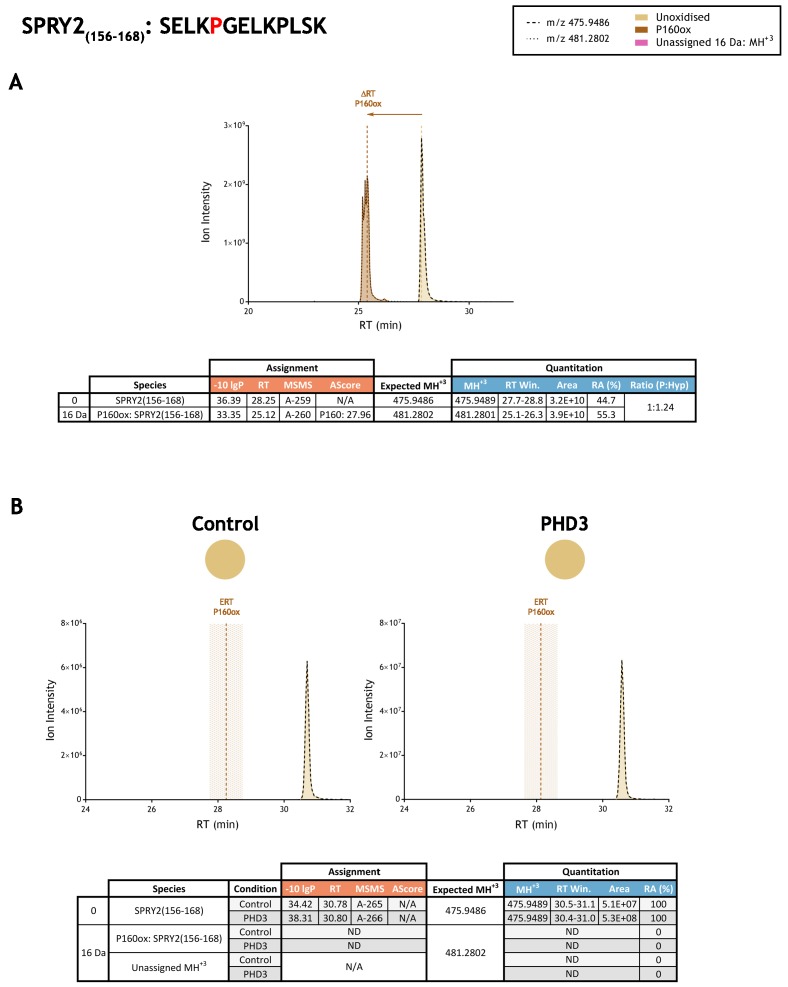
Quantitation of peptide oxidation on SPRY2(156–168) following reaction of full-length sprouty homolog 2 with recombinant PHD3.XIC data presented in (A) shows ion intensity and retention time (RT) characteristics of equimolar synthetic peptide standards for unoxidised and P160ox forms of the SPRY2(156–168) peptide. MSMS assigned species are coloured (see inset); vertical dashed lines define peak maxima used to derive ΔRT values for P160ox. Panel (B) shows comparable XIC data for protease-digested IVTT substrate under control (left) or PHD3-reacted (right) conditions. Peaks corresponding to unoxidised SPRY2(156–168) were assigned by MSMS (see inset for colour code); P160ox was not detected. The estimated RT (ERT) for P160ox, derived from (A), is indicated by dashed vertical line, shading corresponds to a 1 min RT window. Unassigned ions of compatible mass over charge for hydroxylation were not observed across the elution window. Quantitative data for observed species are presented as pie charts with XIC data. Assignment and quantitation data are tabulated below each panel, table headers are as follows: (−10lgP) significance score of leading assignment at given (RT) with ambiguity score (AScore) for PTM localisation and reference to primary MSMS data in Supplementary file 1. Quantitative data reports ion counts (Area) of observed masses (MH+3) integrated over time (RT Win.), expressed as relative abundance (RA). Data on detection efficiency for synthetic peptides (Panel A, P: Hyp) is an aggregated ratio of prolyl (P) to hydroxyprolyl (Hyp) containing species.